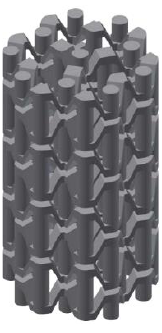
Figure 3: Isometric view of a four-layered lattice for used in SHPB